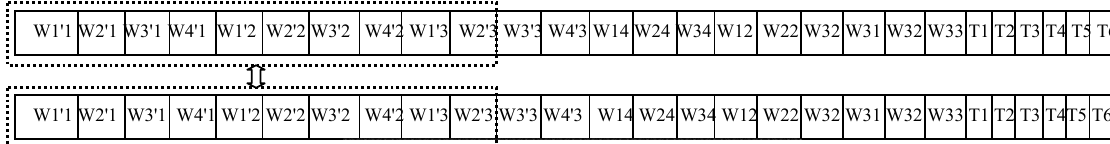
Fig. 4: Random crossover